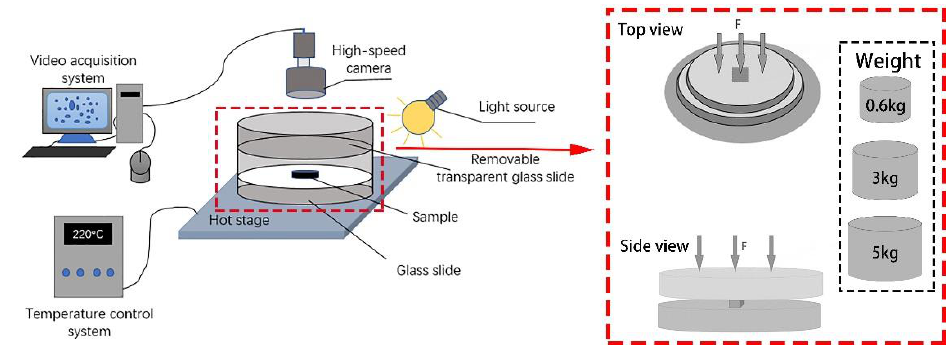
Figure 1. Simple optical microscope visualization device model diagram. Table 1. The proportion table of PP composite foam material.